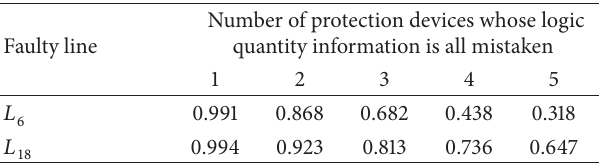
Table 7: WABP performance under mistaken condition B when a fault occurs on 𝐿 6 or 𝐿 18